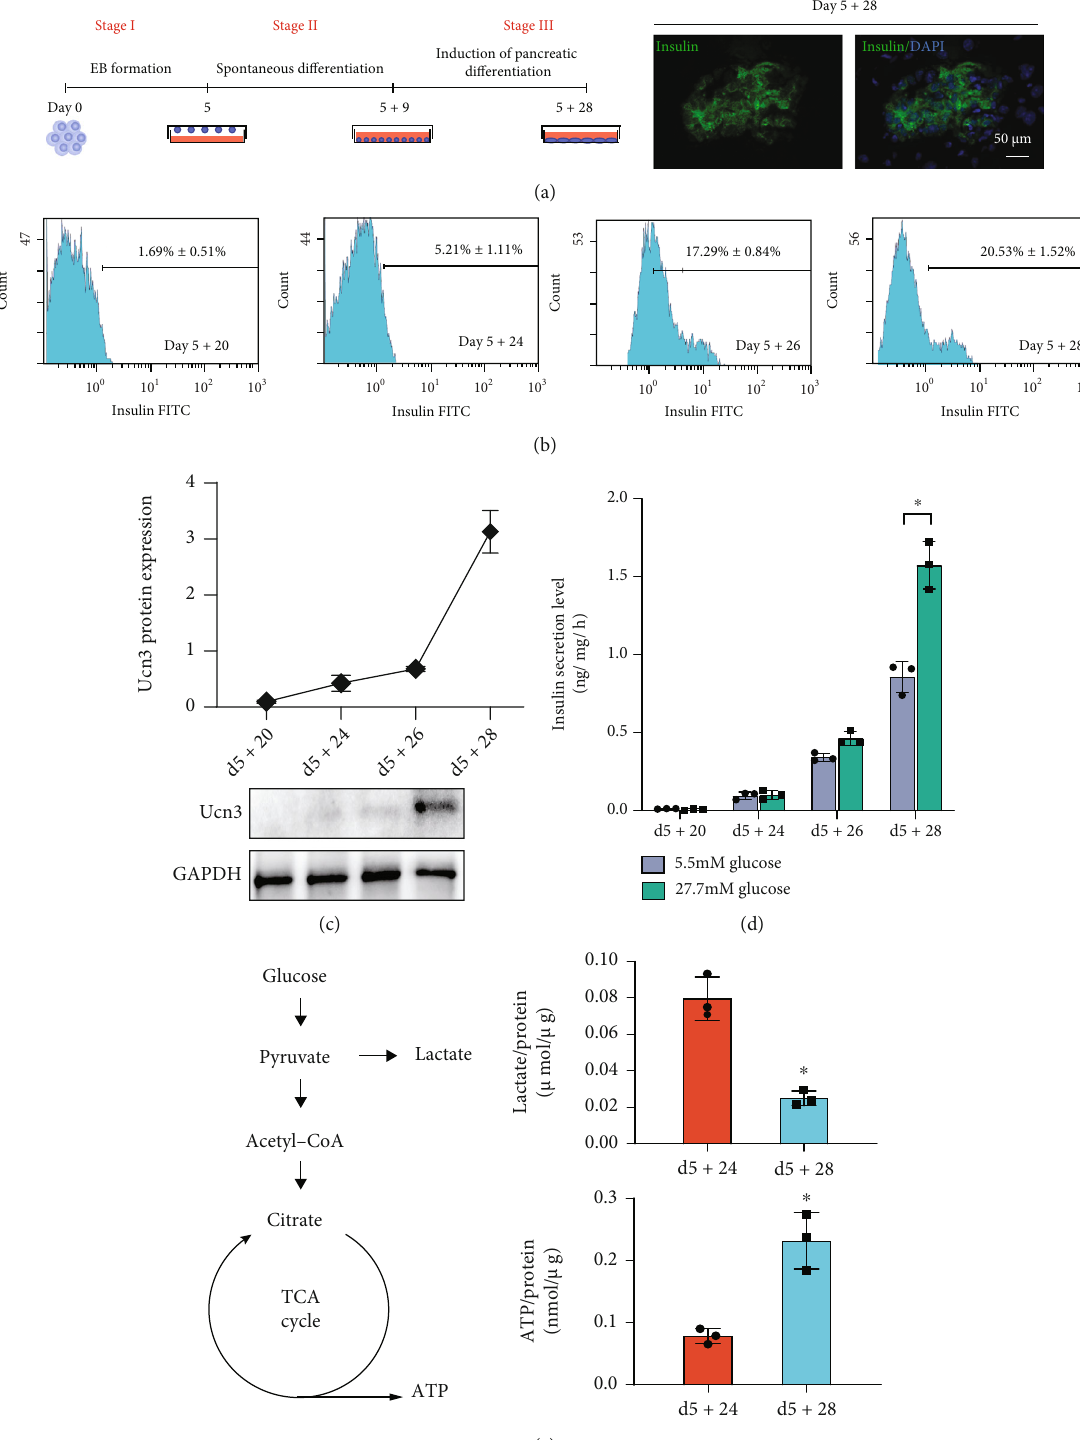
Figure 1: Di ff erentiation of functional insulin cells from embryonic stem cells. (a) Three-stage protocol of insulin cell di ff erentiation. Insulin expression determination in the induced cells at termination day by immuno fl uorescence stain. Bar = 50 μ m. (b) Flow cytometry assay demonstrated the ratios of insulin cells at di ff erent days. (c) Ucn3 protein expression during the insulin-positive cell generation period. (d) Released insulin of induced cells was analyzed by ELISA kit. (e) Lactate and ATP production after one-hour 2.5mmol/L glucose stimulation. The lactate and ATP levels were compared to the total protein amount. Values were normalized with total protein contents. n = 3 . Values represent mean ± S : D . ∗ P < 0 : 05